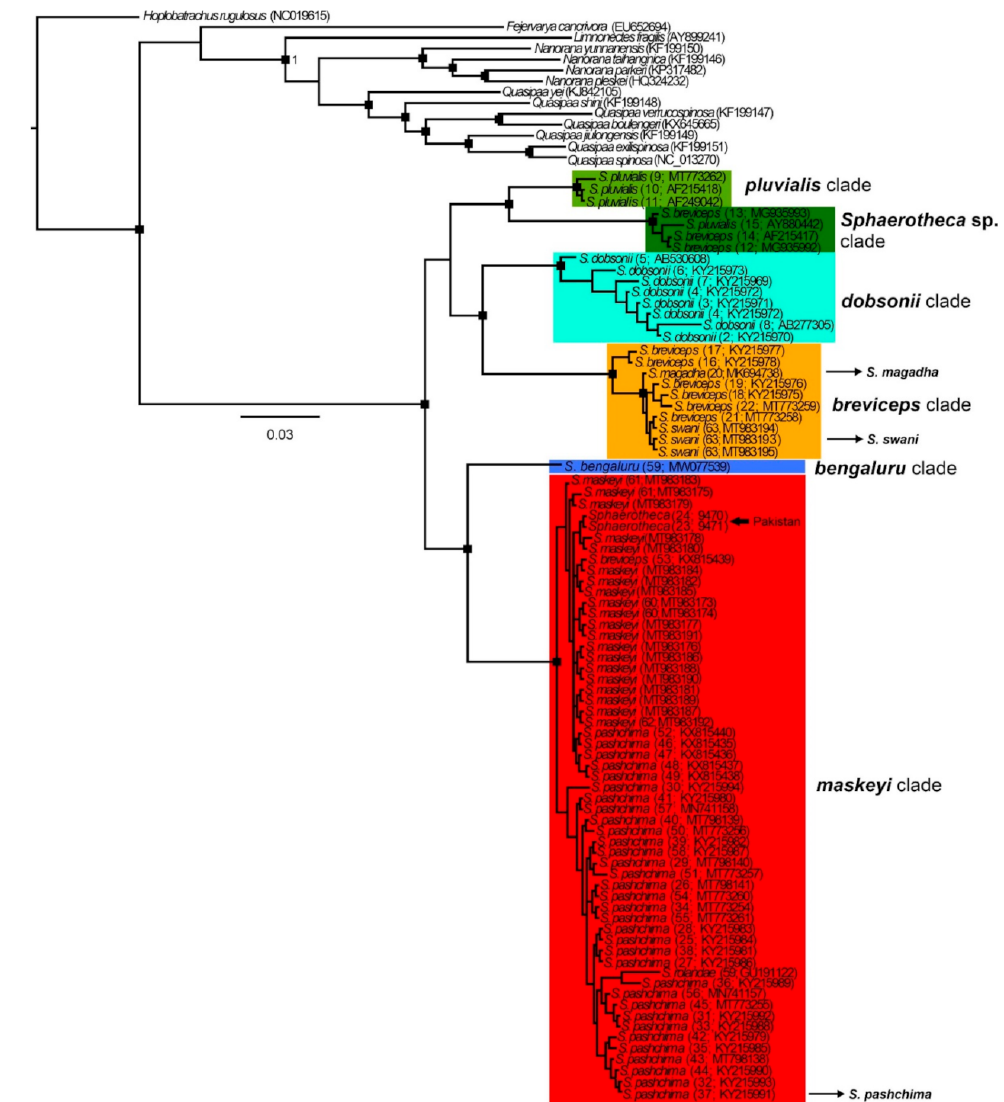
Figure 3. Bayesian inference tree of the genus Sphaerotheca based on 16S rRNA (~600 bp) sequence data. Rectangles at branch nodes refer to posterior probabilities ≥ 0.95. For maximum-likelihood trees, see supplementary Figure S1. The details on the geographic distribution of detected clades can be seen in Figure